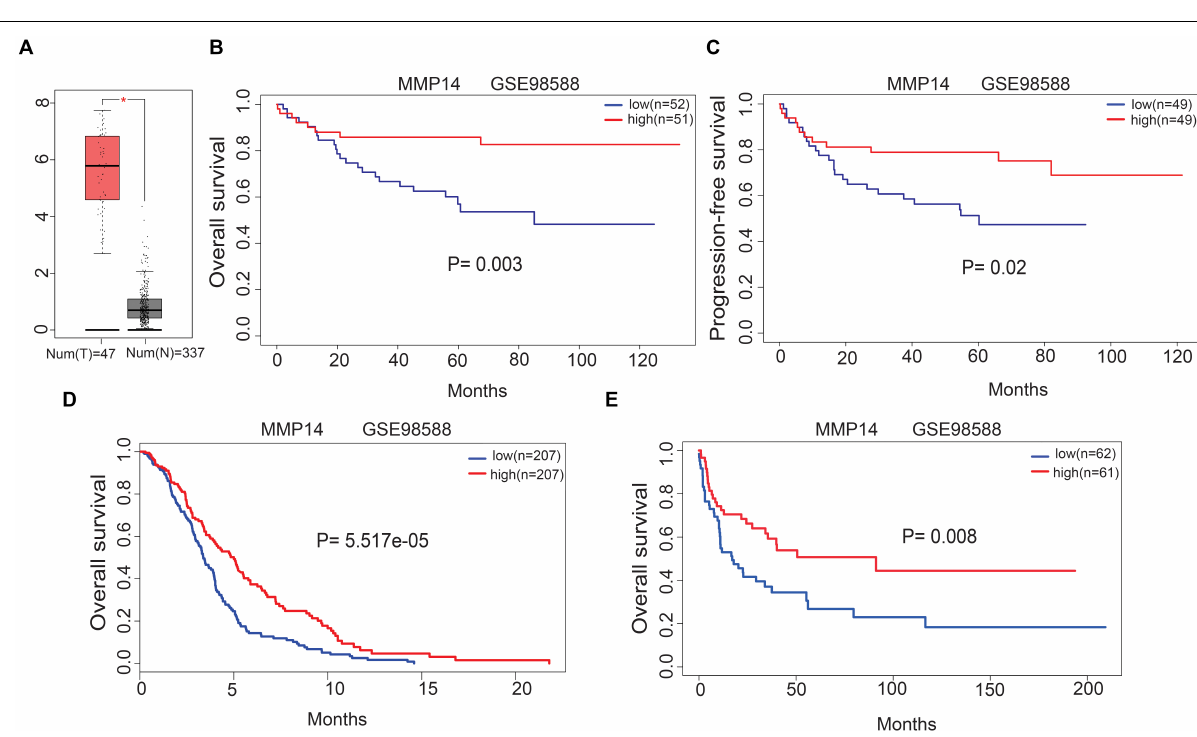
FIGURE 2 | (A) Matrix metallopeptidase 14 (MMP14) expression levels in DLBCL tissues [Gene Expression Profiling Interactive Analysis (GEPIA) database]. T, tumor; N: normal tissue. (B) Correlation of MMP14 expression with overall survival (OS) in the GSE98588 dataset. (C) Correlation of MMP14 expression with progression-free survival (PFS) in the GSE98588 dataset. (D) Comparison of MMP14 expression with OS in the GSE10846 dataset. (E) Comparison of MMP14 expression with OS in the GSE4475 datasets (validation